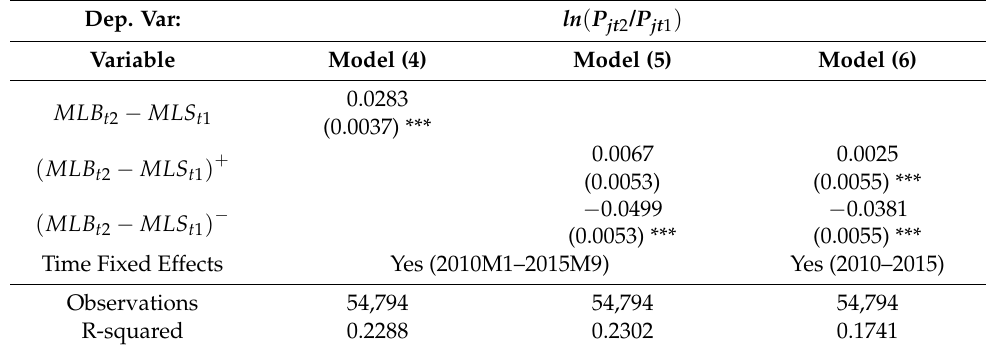
Table 5. Results of the repeat-sales models of Equations (4)–(6).